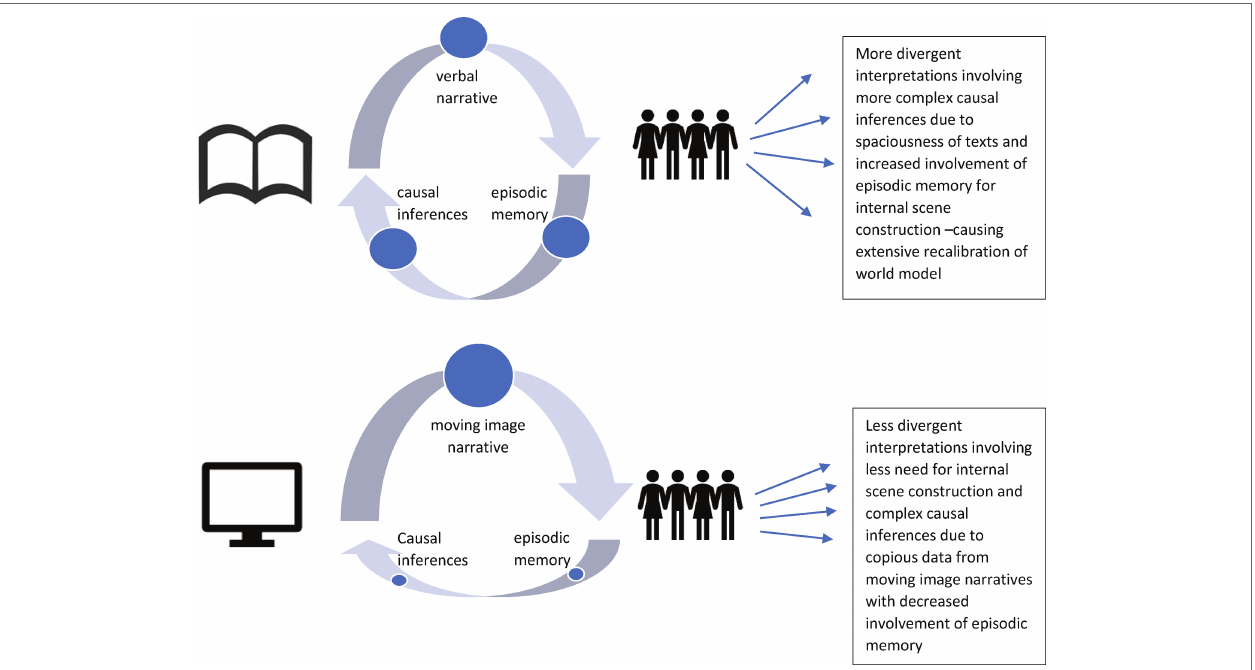
FIGURE 1 | Summary comparison of verbal and moving image narrative